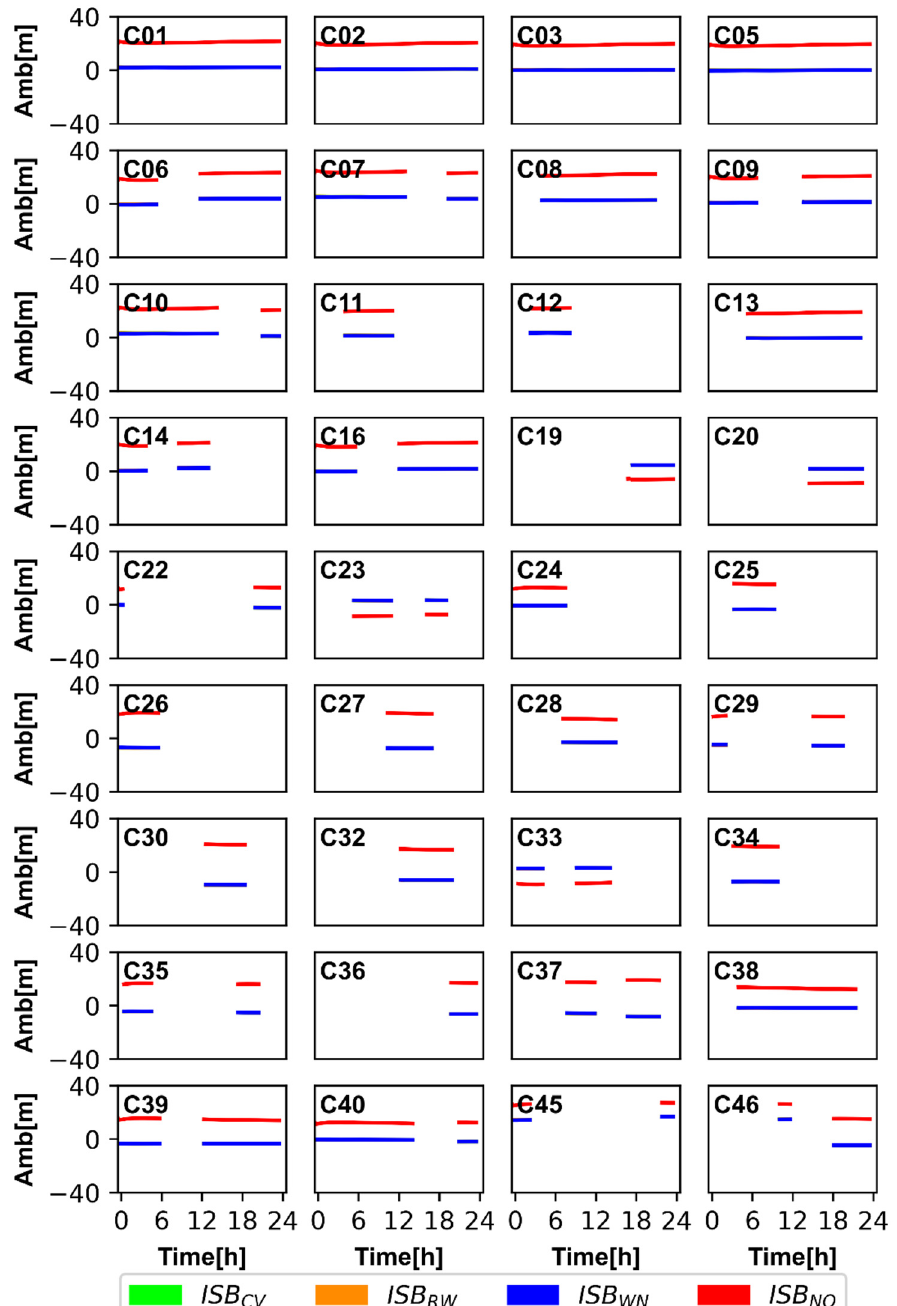
Figure 12. The ambiguities of BDS-2 (B1I/B3I) and BDS-3 (B1C/B2a) satellites for four ISB stochastic models based on GFZ products at XIA1 station.